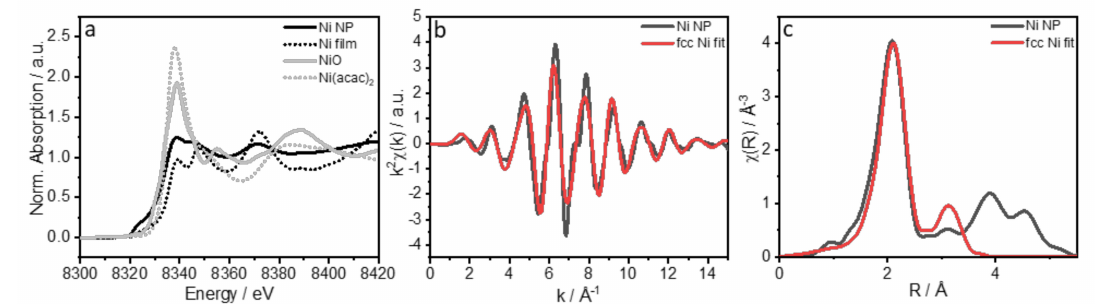
Figure 3. ( a ) Normalized Ni K-edge XANES-spectra of NiNPs (black straight), a Ni film (black dots), NiO (grey straight), and Ni(acac) 2 used as precursor (grey dots); ( b ) visualization of k 2 -weighted extended X-ray absorption fine structure (EXAFS) oscillations in k-space of NiNPs (black) and fcc Ni bulk fit (red); ( c ) EXAFS oscillations as a function of the distance R obtained by Fourier transformation of NiNPs (black) and fcc Ni bulk fit